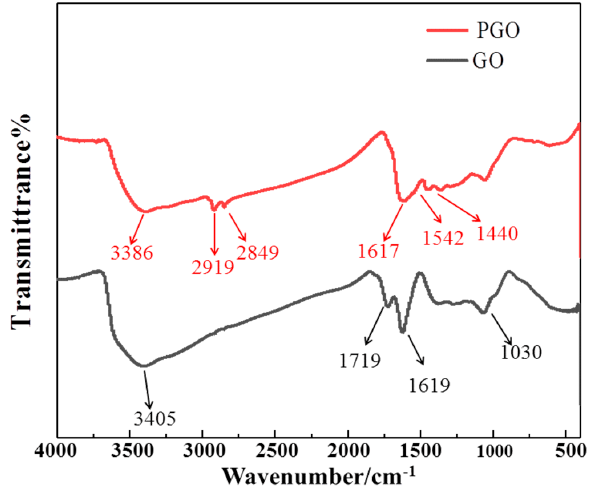
Figure 1. FTIR spectrum of PGO and GO.